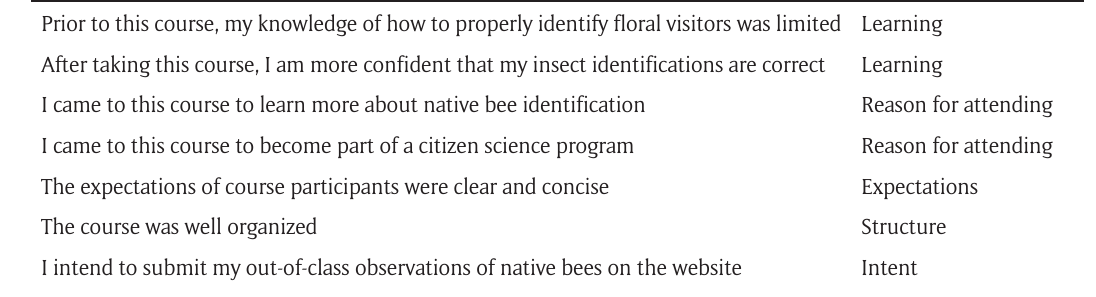
Table 1: Statements used in Likert-scale questionnaire of trainees. Volunteers were asked to respond to each statement on a 1 to 5